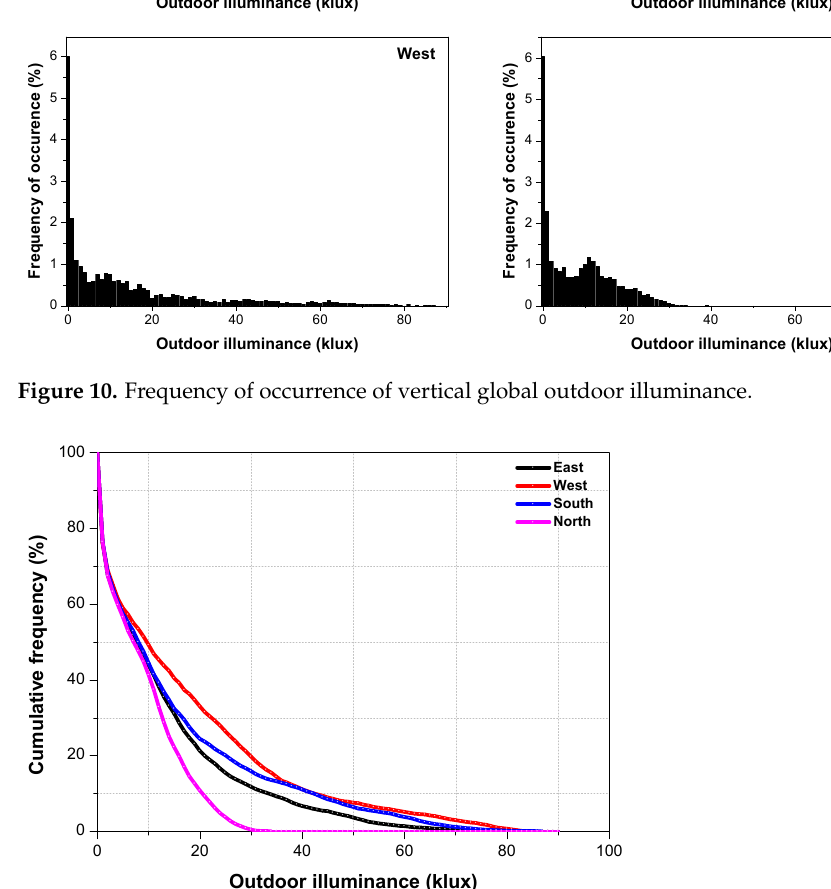
Figure 11. Cumulative frequency of vertical outdoor global illuminance .